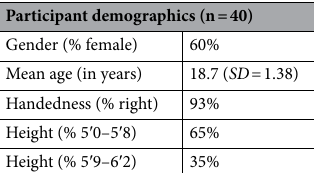
Table 2. Participant demographic